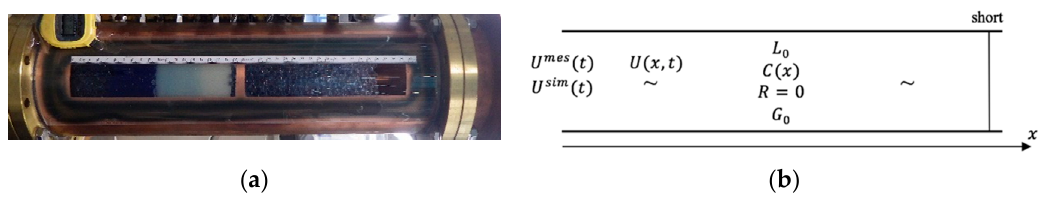
Figure 4. ( a ) Picture of the coaxial cell and ( b ) corresponding model of the transmission line. By discretizing the signal U ( x , t ), the Equation (2) can be solved using the Finite-Difference-Time Domain-Method (FDTD) [33].